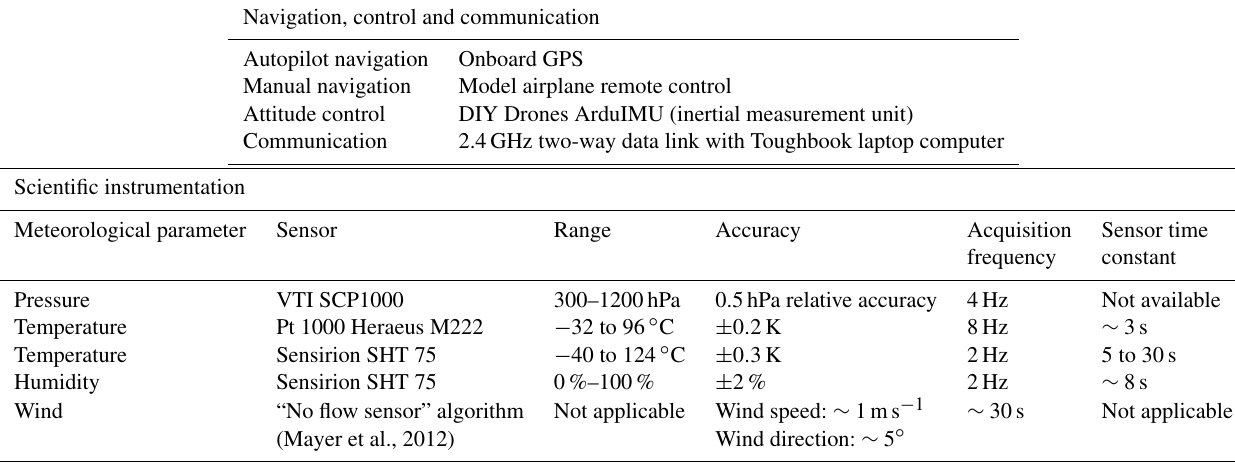
Table 2. SUMO sUAS navigation, control and communication and scientific instrumentation sensor range, accuracy, acquisition frequency and time constant, as specified by the manufacturer (based on Reuder et al., 2012; Cassano,